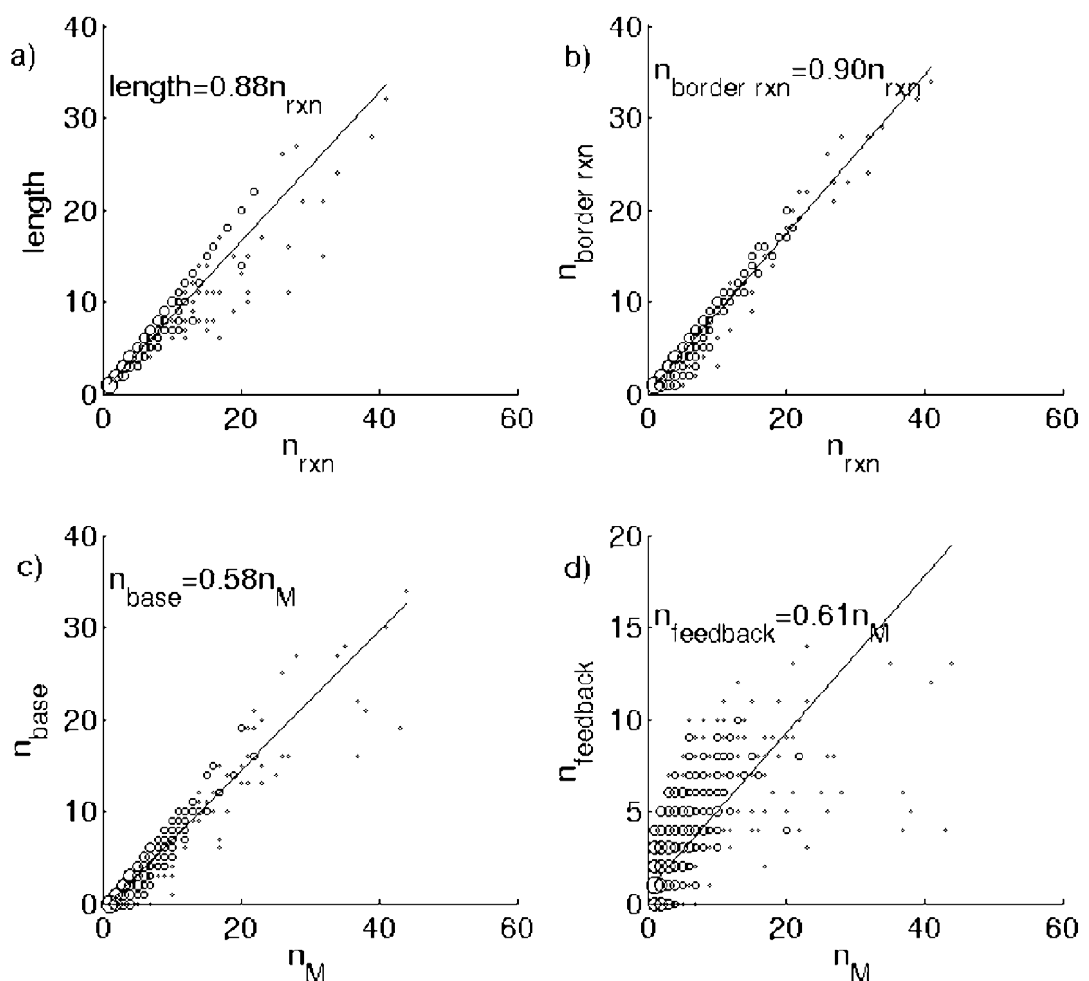
Figure 8. Various linear relationships on the individual pathways. Approximately linear relationship between a) pathway’s length and its number of reactions n rxn , ) b) the number of border reactions, n border rxn, and the total number of reactions, n rxn , c) the number of base metabolites, n base, and the total number of metabolites, n M , d) the number of metabolites receiving feedback, n feedback, and the total number of metabolites, n M . These different geometrical properties of individual pathways are illustrated in Figure 4. Sizes of circles are proportional to the logarithm of the number of discrete (x, y) pairs contributing to this point.